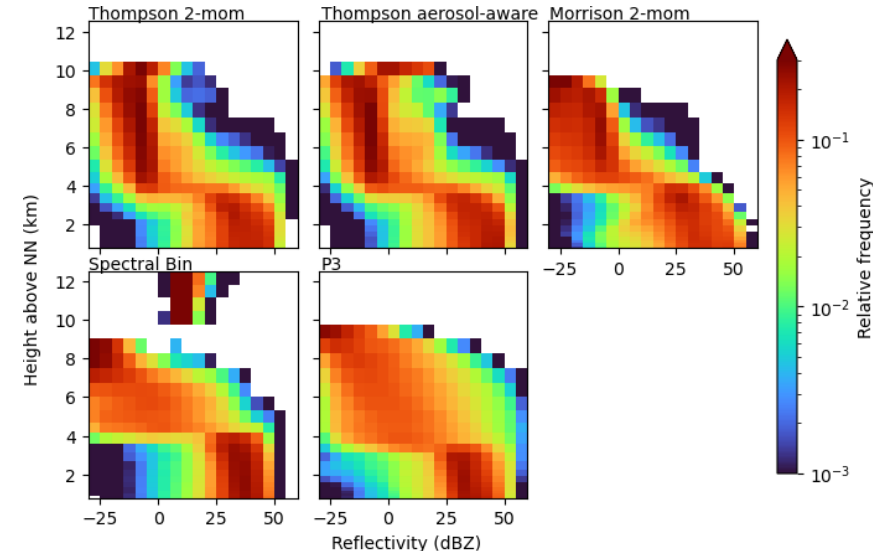
Figure B1. CFADs of simulated reflectivity of the rain hydrometeor class over 5 convective days in 2019.